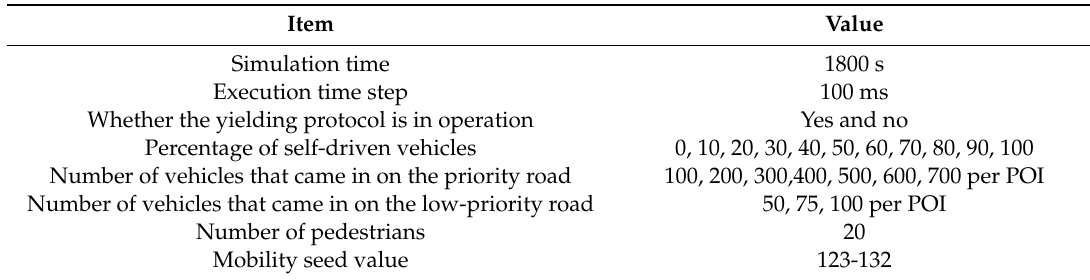
Table 7. Simulation conditions.